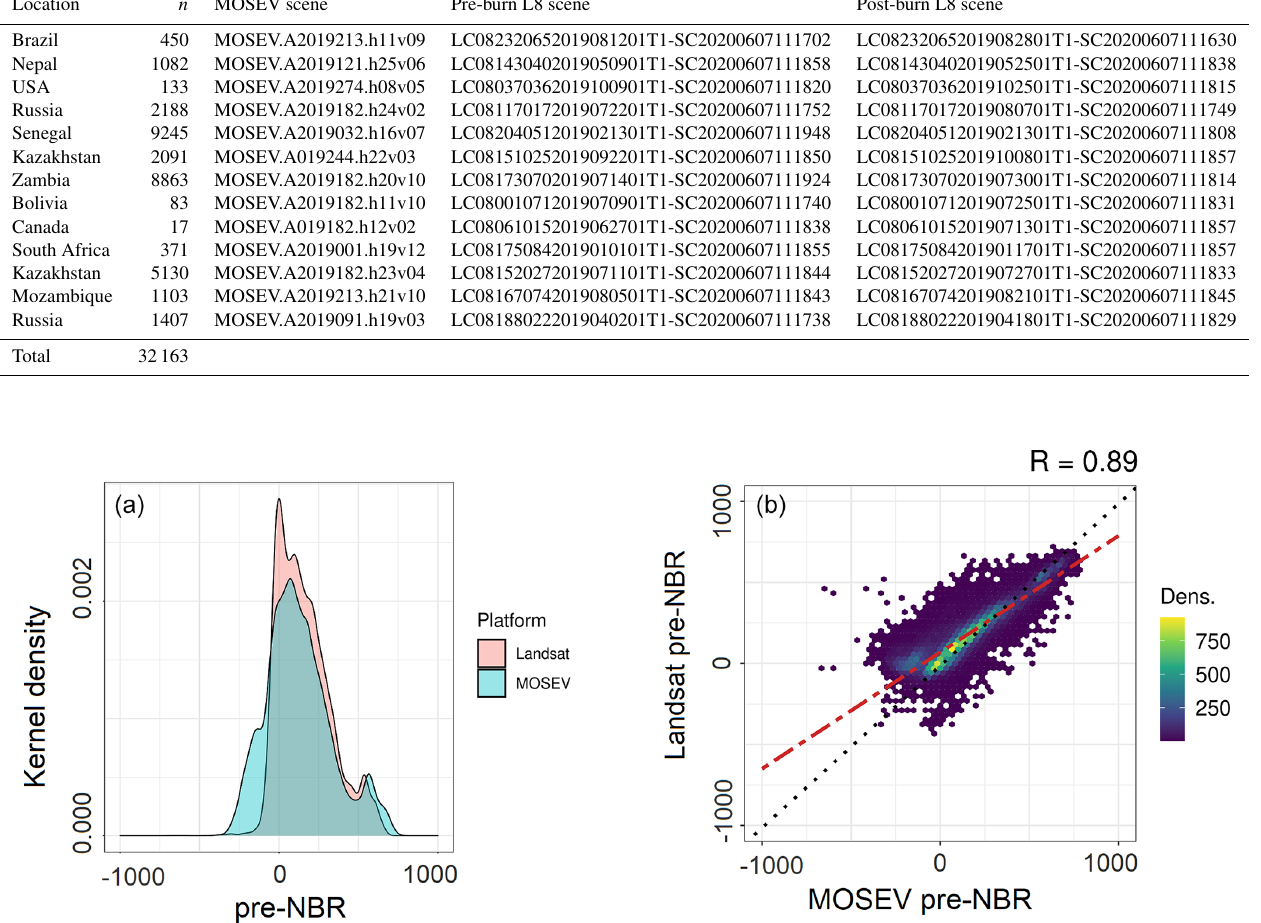
Figure A1. Gaussian kernel densities (a) and scatterplots (b) showing the relationships between the pre-burn NBR spectral index included in the MOSEV database and the equivalent obtained from 13 Landsat-8 scenes randomly distributed across the globe ( n = 32163). R is Pearson’s correlation coefficient, and Dens. signifies density.